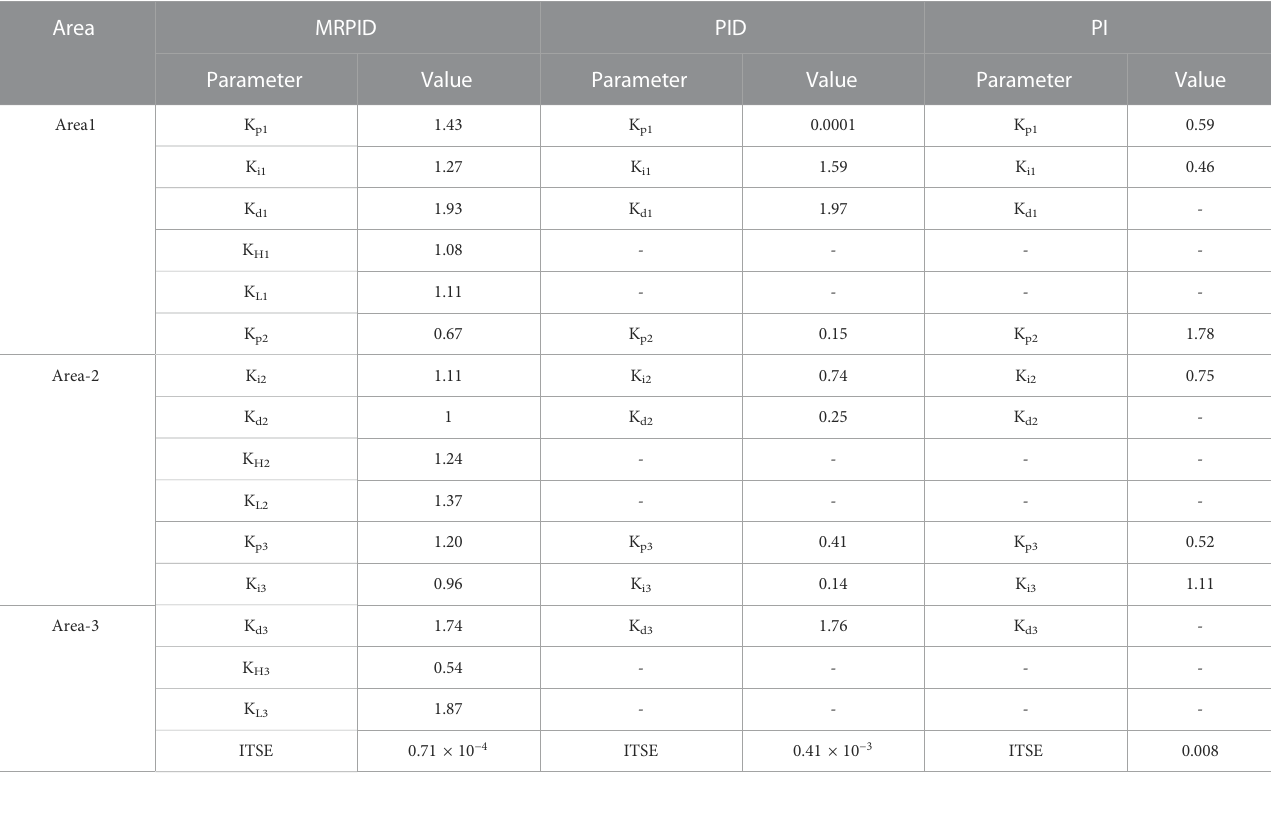
TABLE 2 Controllers gain for a three-area interconnected PS.